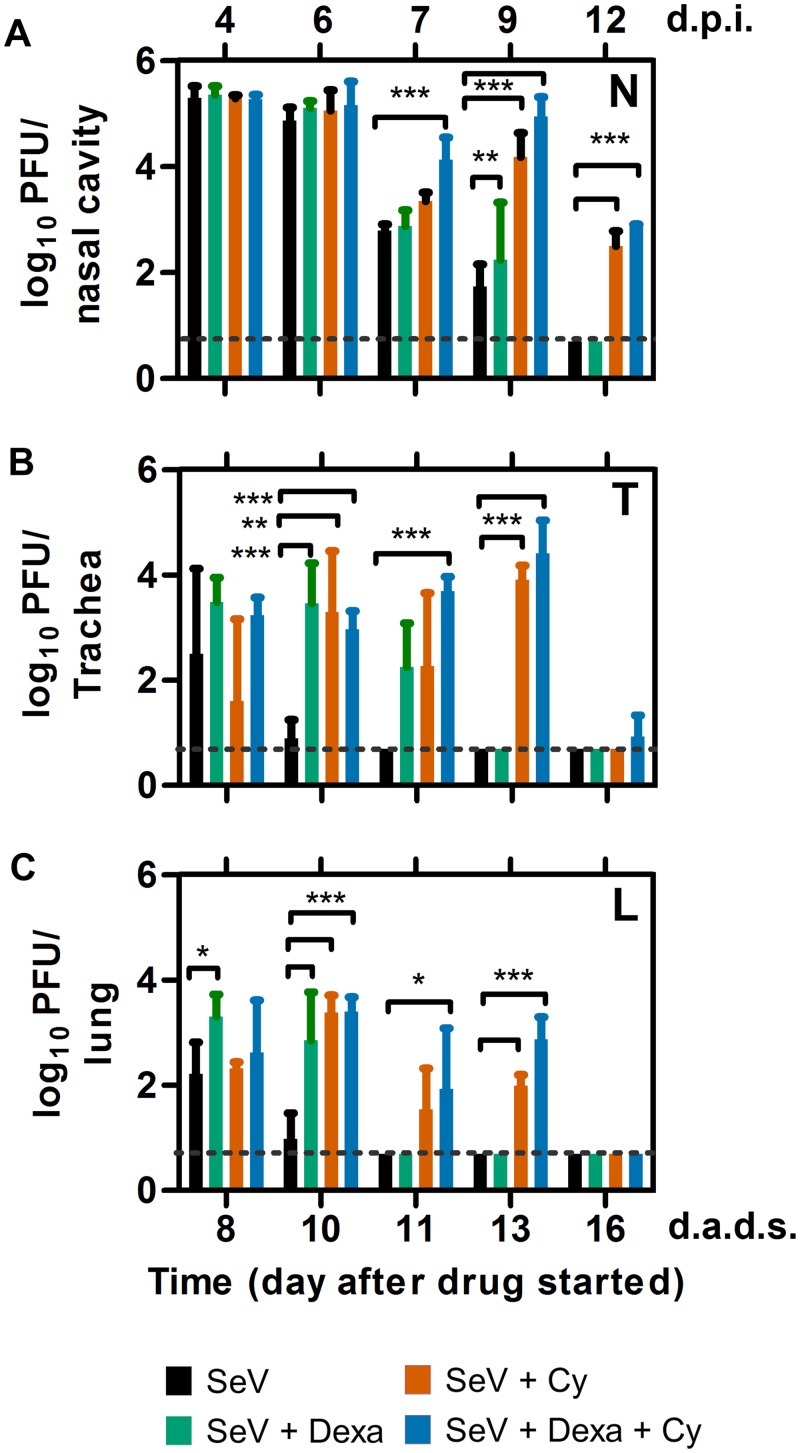
Viral load in the respiratory tracts of mice inoculated with SeV 4 days after treatment with Dexa and/or Cy.(A–C) Viral loads in the nasopharynx (A), trachea (B), and lungs (C). The data shown are averages of 3 animals at each time point. Bar colors for the groups are as follows: PBS (black), Dexa (green), Cy (orange), and Dexa + Cy (blue). Dashed lines represent the limit of detection. Error bars represent standard deviation. d.p.i., days postinfection; d.a.d.s., days after drug started. Statistics: 2-Way ANOVA; *P < 0.05, **P < 0.01, ***P < 0.001.